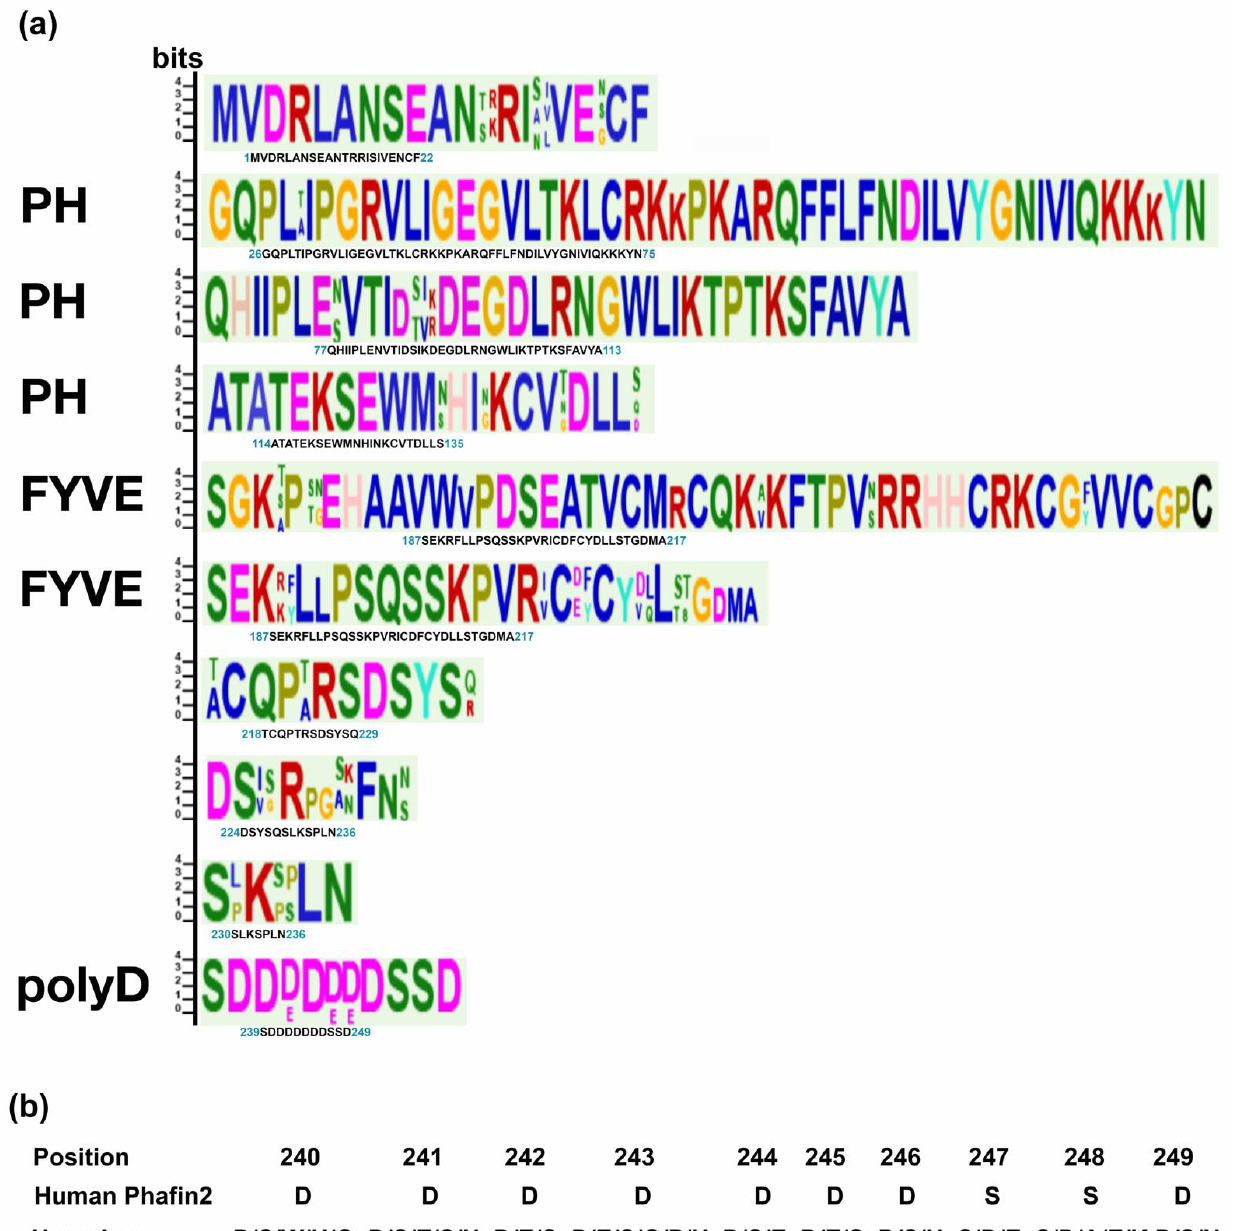
Figure 2. Consensus sequences found in mammalian Phafin2 and PH-, FYVE-, and polyD-containing proteins. ( a ) Sequences associated with the PH and FYVE domains as well as with the polyD motif are labeled. Logo sequences were obtained from protein sequences of human origin. ( b ) Substitutions in the polyD motif identified in Phafin2 homologs.